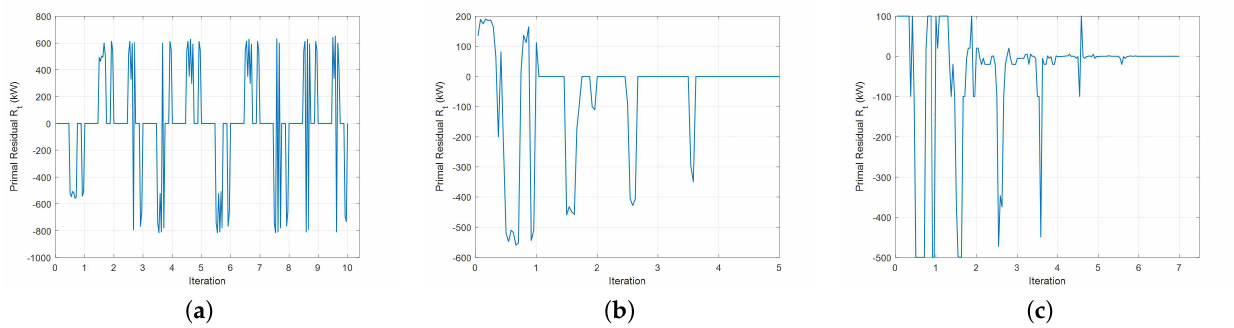
Figure 5. The generation–load mismatch R t of different methods in grid-connected mode. ( a ) Square of 1-norm. ( b ) Square of 2-norm. ( c ) Linearized square of 2-norm.